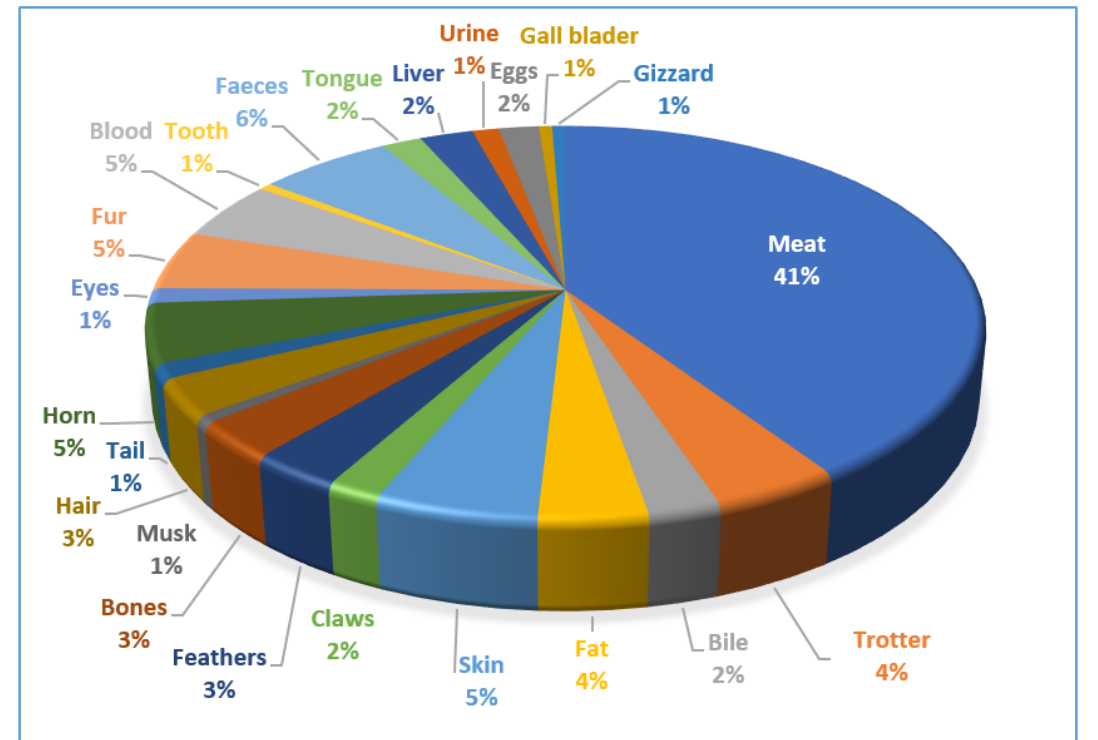
Figure 2. Percentage of body parts used by ethnic communities for ethnozoological